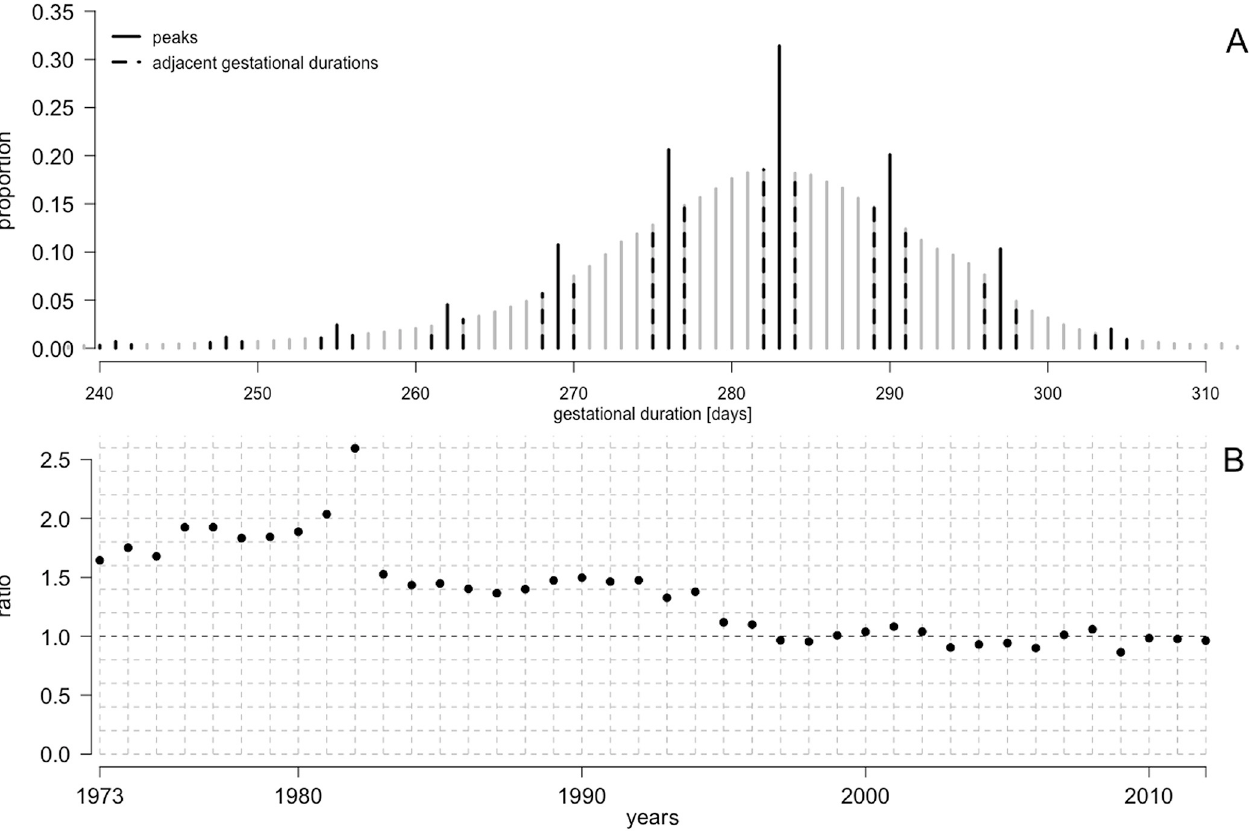
Fig 3. Gestational duration distribution, Swedish Medical Birth Register, 1973–2012. A) Gestational duration distribution. Gestational durations that occurred at higher frequency than expected (peaks) are marked by solid black lines. Sample was reduced to pregnancies registered from 1973 to 1982, that is, to the period in which peaks were most common. Adjacent gestational durations to peaks are marked by black dashed lines. B) Average ratio of peaks’ frequency to the mean of adjacent gestational duration frequency from 1973 to 2012. Sample size: n = 3 940